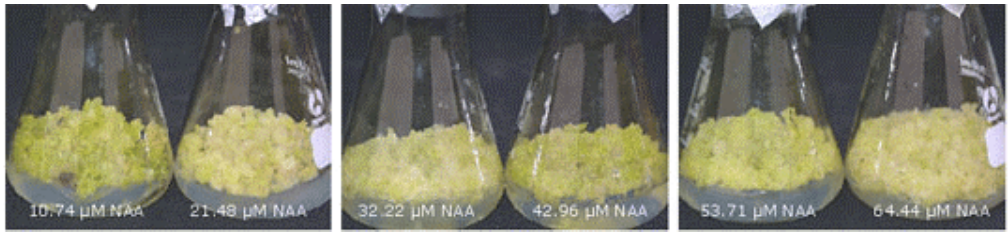
FIGURE 1 . Calli proliferation of Moris cultivar under six different levels of NAA, after 12 weeks of